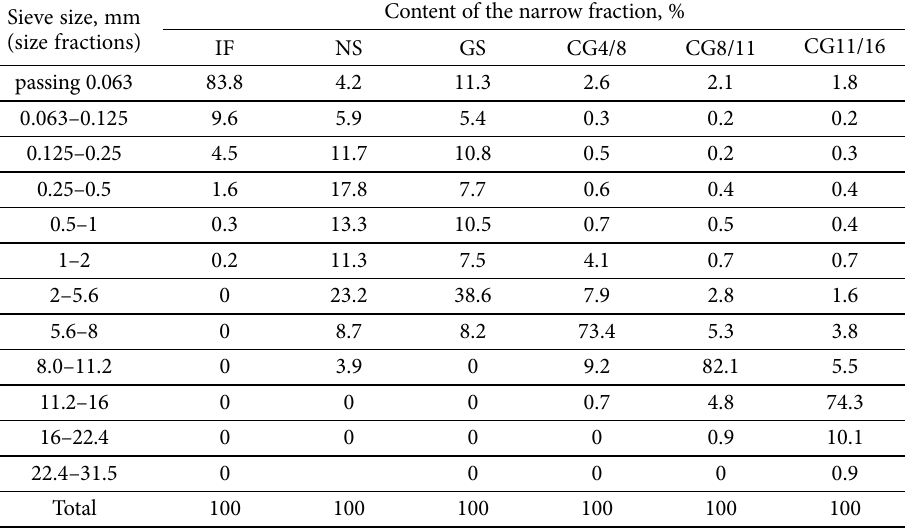
Table 6. The results of simulating minerals and bitumen content in the asphalt mixture Technological limitation